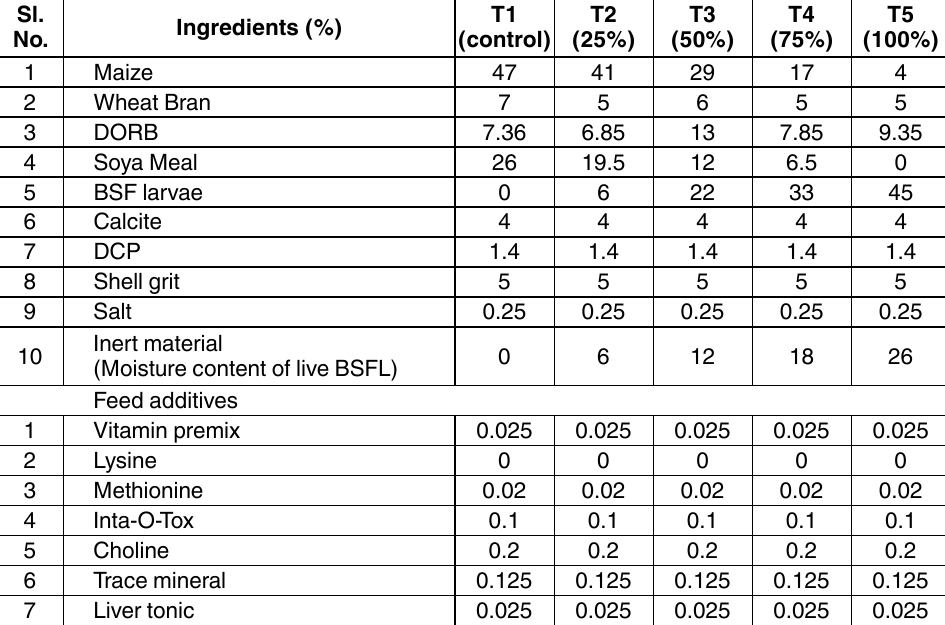
Table 3. Ingredient composition of different experimental diets Sl.